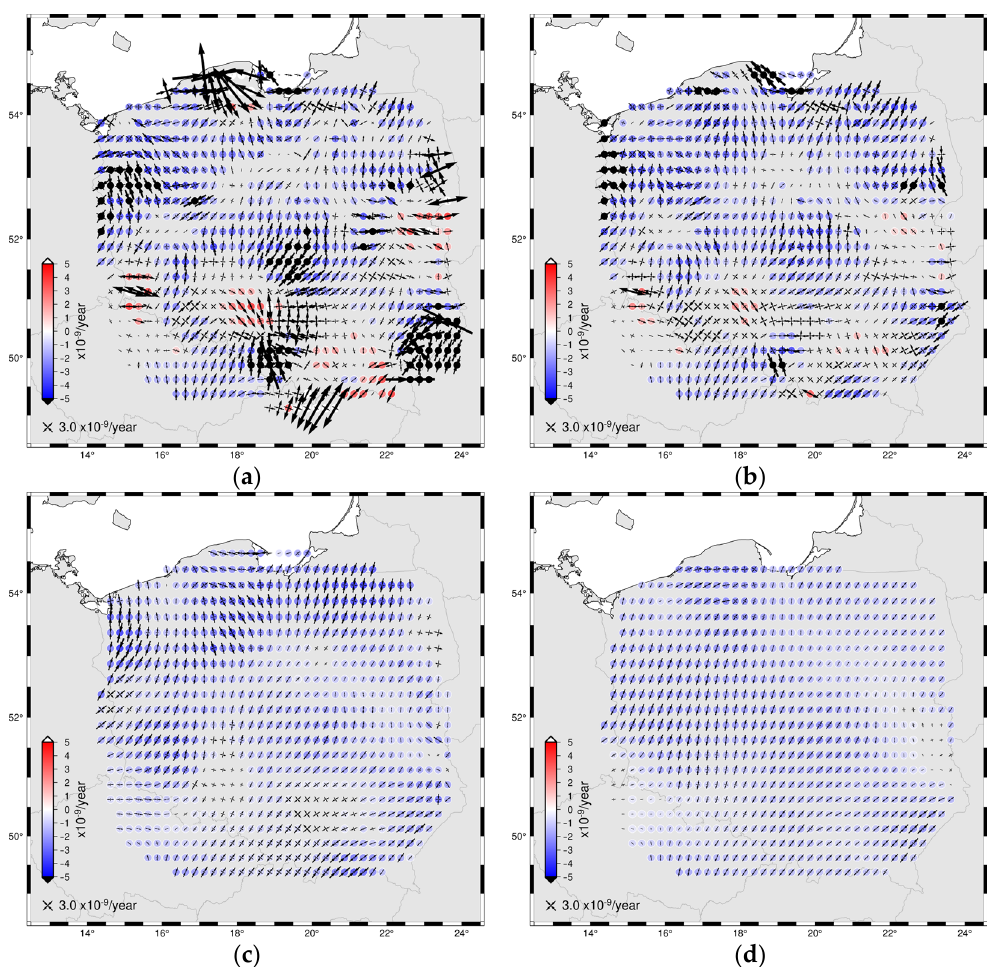
Figure 5. GPS strain rate maps including dilatation strain for initial dataset ( a ), DBF_100 ‐ 5 ( b ), DBF_100 ‐ 15 ( c ), and DBF_100 ‐ 25 ( d ).